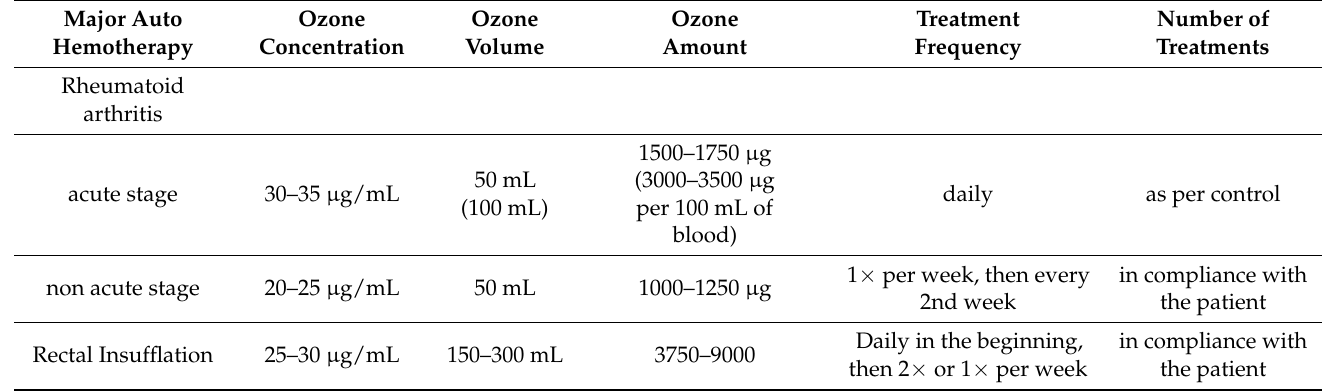
Table 4. Rheumatoid arthritis, treatment